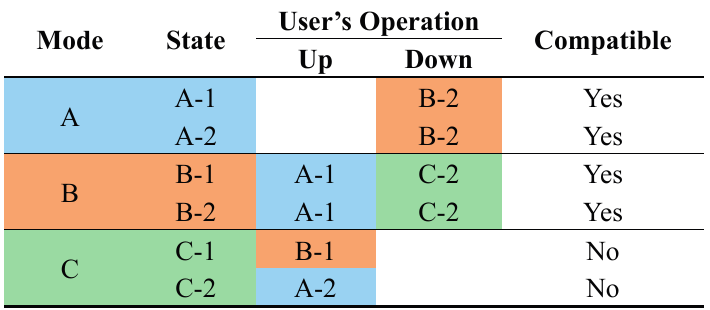
Table 1. User-triggered state and mode transitions in the example machine.